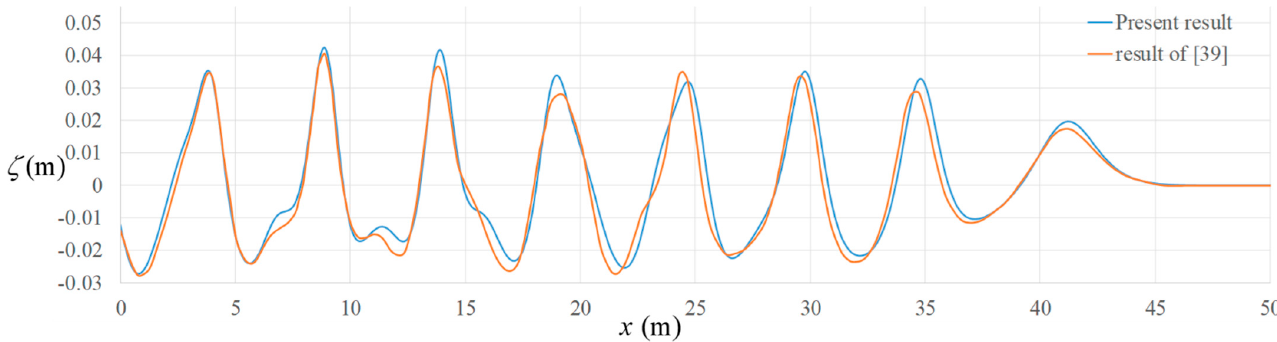
Figure 6. Comparison of the present numerical results with the numerical result of [39] on the free surface profile at t = 21.8 s for the case of nonlinear waves generated by a large stroke harmonic motion of a piston type wave